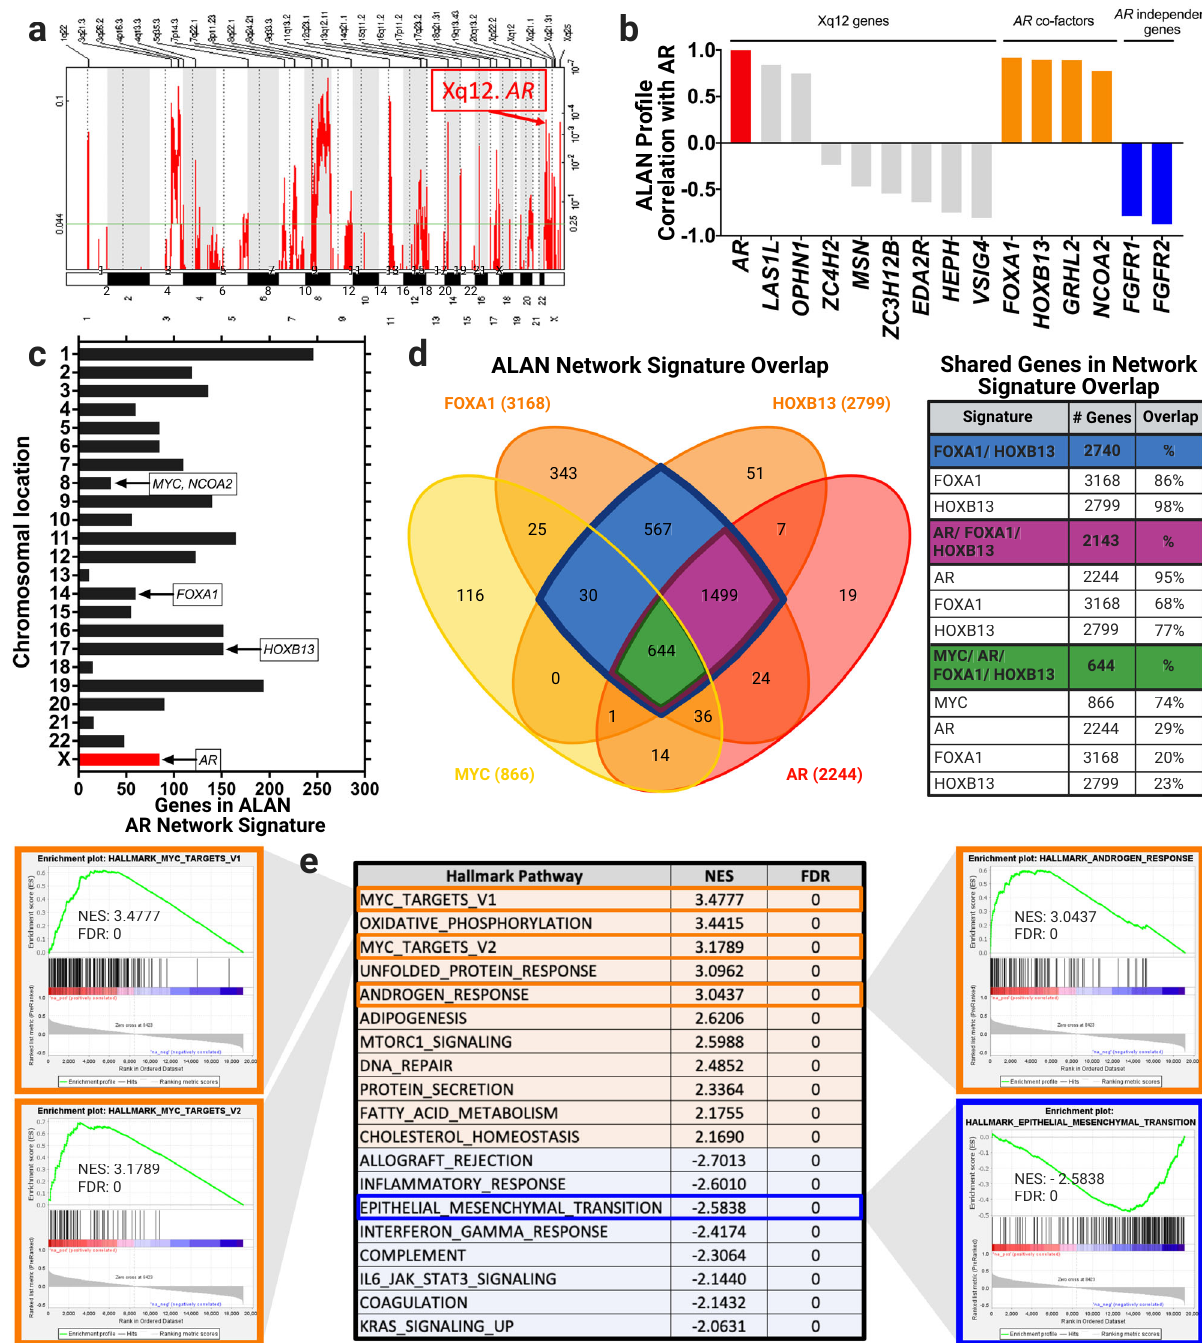
Fig. 2 ALAN identi fi es similar gene behavior between AR and key prostate cancer genes that are intra-chromosomal. a GISTIC2 analysis of primary prostate adenocarcinomas highlighting the focal ampli fi cation of AR (Xq12, n = 9) as a recurrent copy number gain (TCGA PRAD, n = 492). b ALAN pro fi le correlations with AR are shown for other Xq12 genes (gray), AR co-factors (orange), and AR-independent genes (blue). c Chromosomal location of genes in the ALAN AR network signature. Highlighted genes have implications with AR in prostate cancer such as transcription factors MYC (8q24), FOXA1 (14q21), HOXB13 (17q21), and transcriptional co-activator NCOA2 (8q13). d Visual depiction of ALAN network signature overlap between AR (red), MYC (yellow), FOXA1 (orange), and HOXB13 (orange) and their percentage of shared genes. e GSEA Enrichment Plots with NES and FDR statistics of the AR ALAN pro fi le and various Hallmark Gene Signatures derived from ALAN Matrix